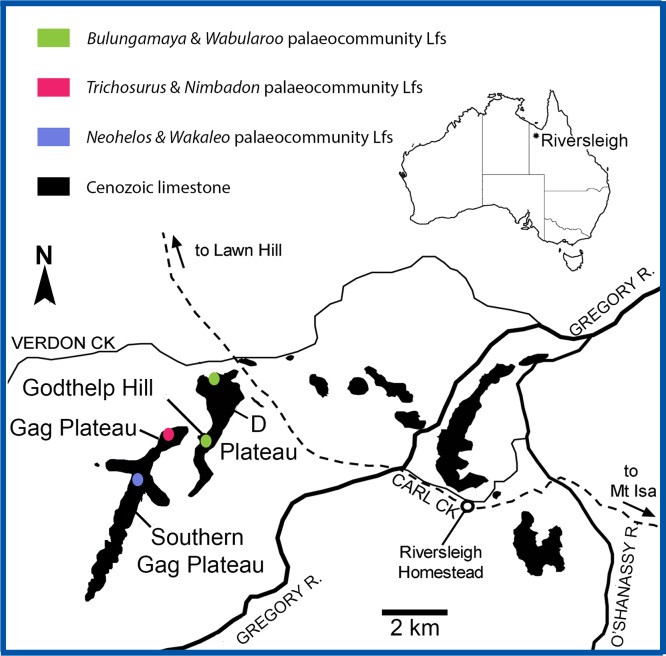
Location of the Riversleigh World Heritage Area, Queensland, Australia and local faunas representing proposed palaeocommunities (after Arena, 2004; Black, 2016).